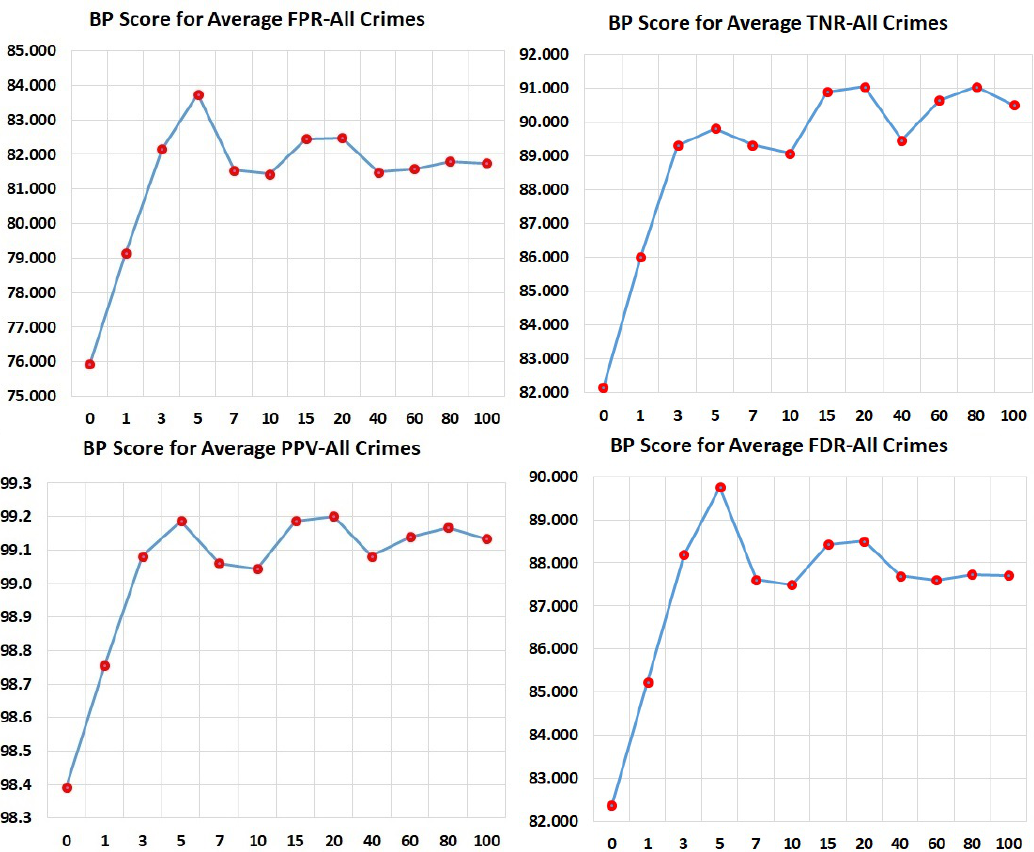
Figure 2. BP Scores by number of past arrest-release cycles (0, 1, 3, 5, 7, 10, 15, 20, 40, 60, 80, 100). Group 3 : BPS-Avg.False-Positive Rate, BPS-Avg. True-Negative Rate, BPS-Avg. Positive Predictive Value, Avg.False Discovery Rate. Averages : Computed using 10 iterations of Monte Carlo